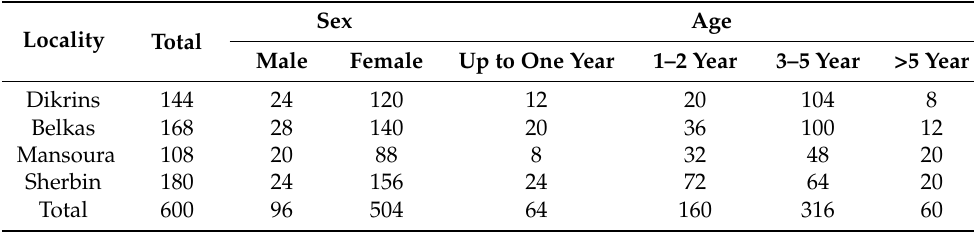
Table 1. Locality and ages of examined